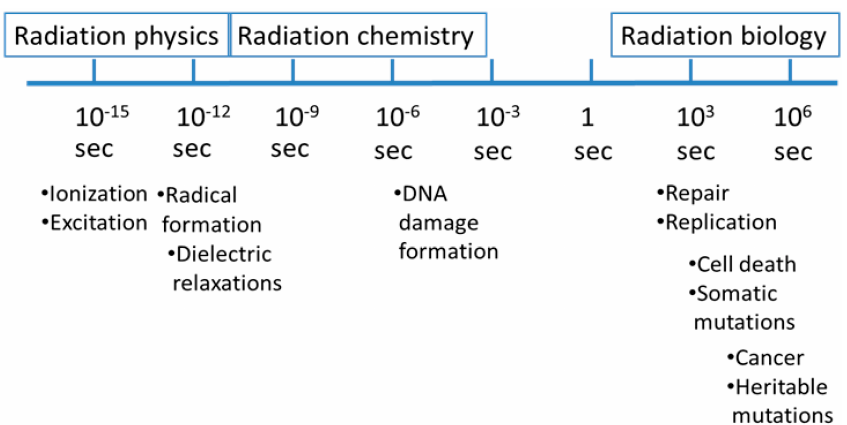
Figure 19. Time scales of major events that lead to biological effects of ionizing radiation. Above the scale bar are shown the corresponding research fields that investigate the